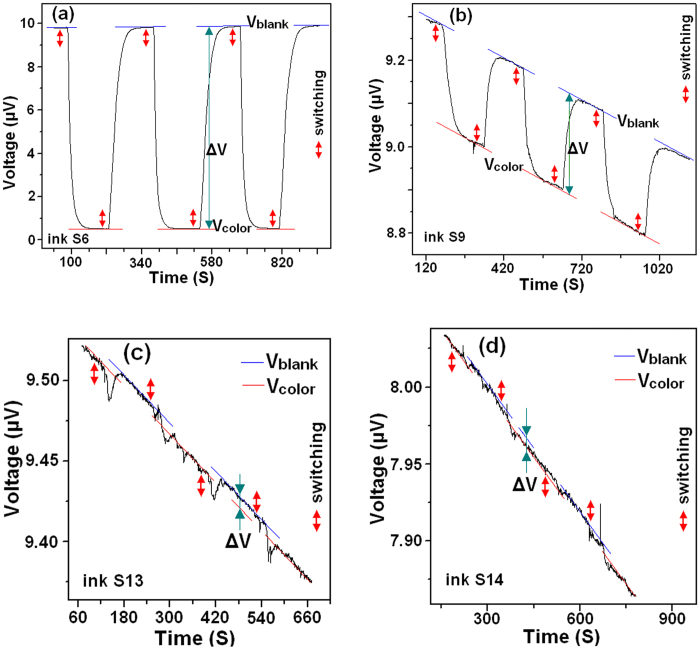
Measurement results of (a) sample 6, (b) sample 9, (c) sample 13 and (d) sample14 by using the MWC-based photometer.